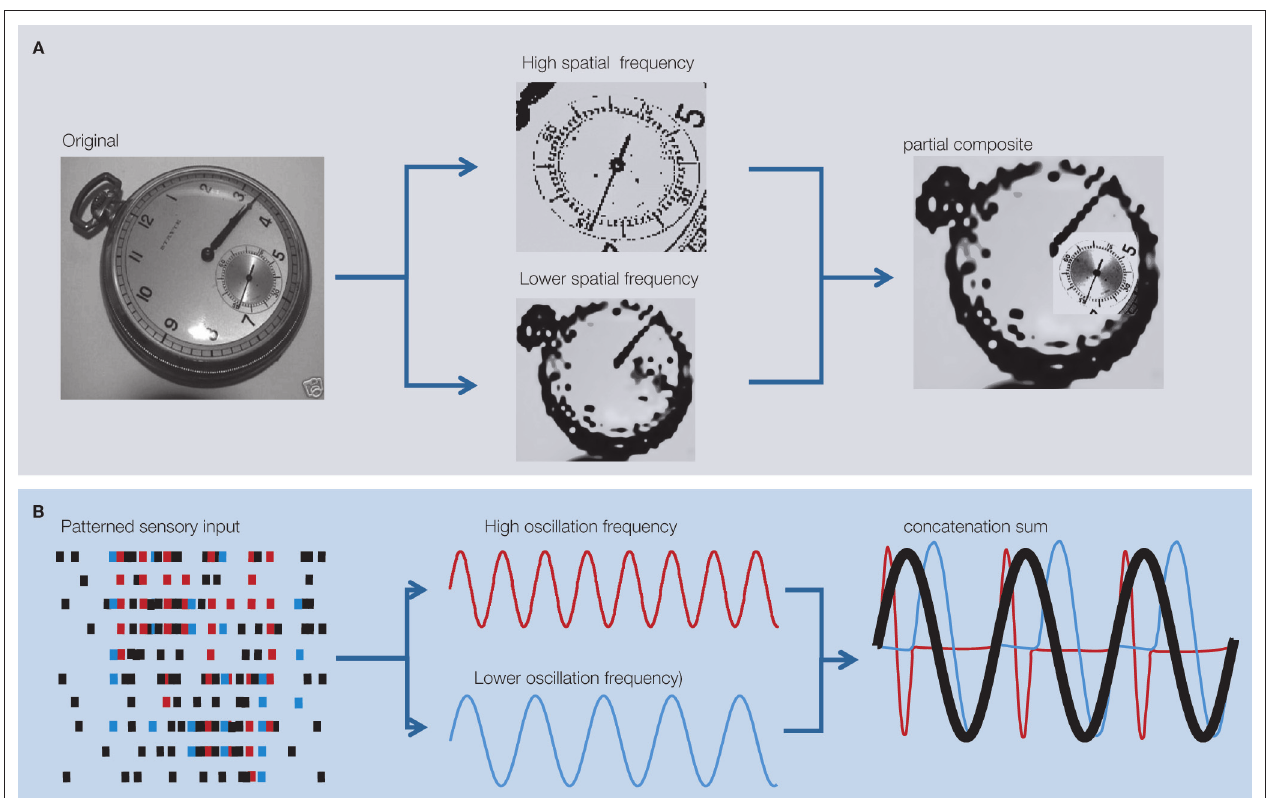
Figure 5 | A possible role for period concatenation in multi-scale sensory processing. (A) What is the most efficient way to recognise the smaller dial of a pocket watch as secondary to the main dial? The image on the left is rendered from a 512 × 512 pixel digital image. From this it is easy to answer the above question, but a very large amount of information is needed ( > 260 k pixels). If the image is split into two different spatial scales the process can be achieved more efficiently. The upper image in the middle panel is a downsampled, smoothed representation of the secondary dial (rendered from 128 × 128 pixels). The lower image in the middle panel is an identically downsampled, smoothed version of the entire image (again, rendered from 128 × 128 pixels). A partial composite of the information held at these two spatial scales provides sufficient information to answer the above